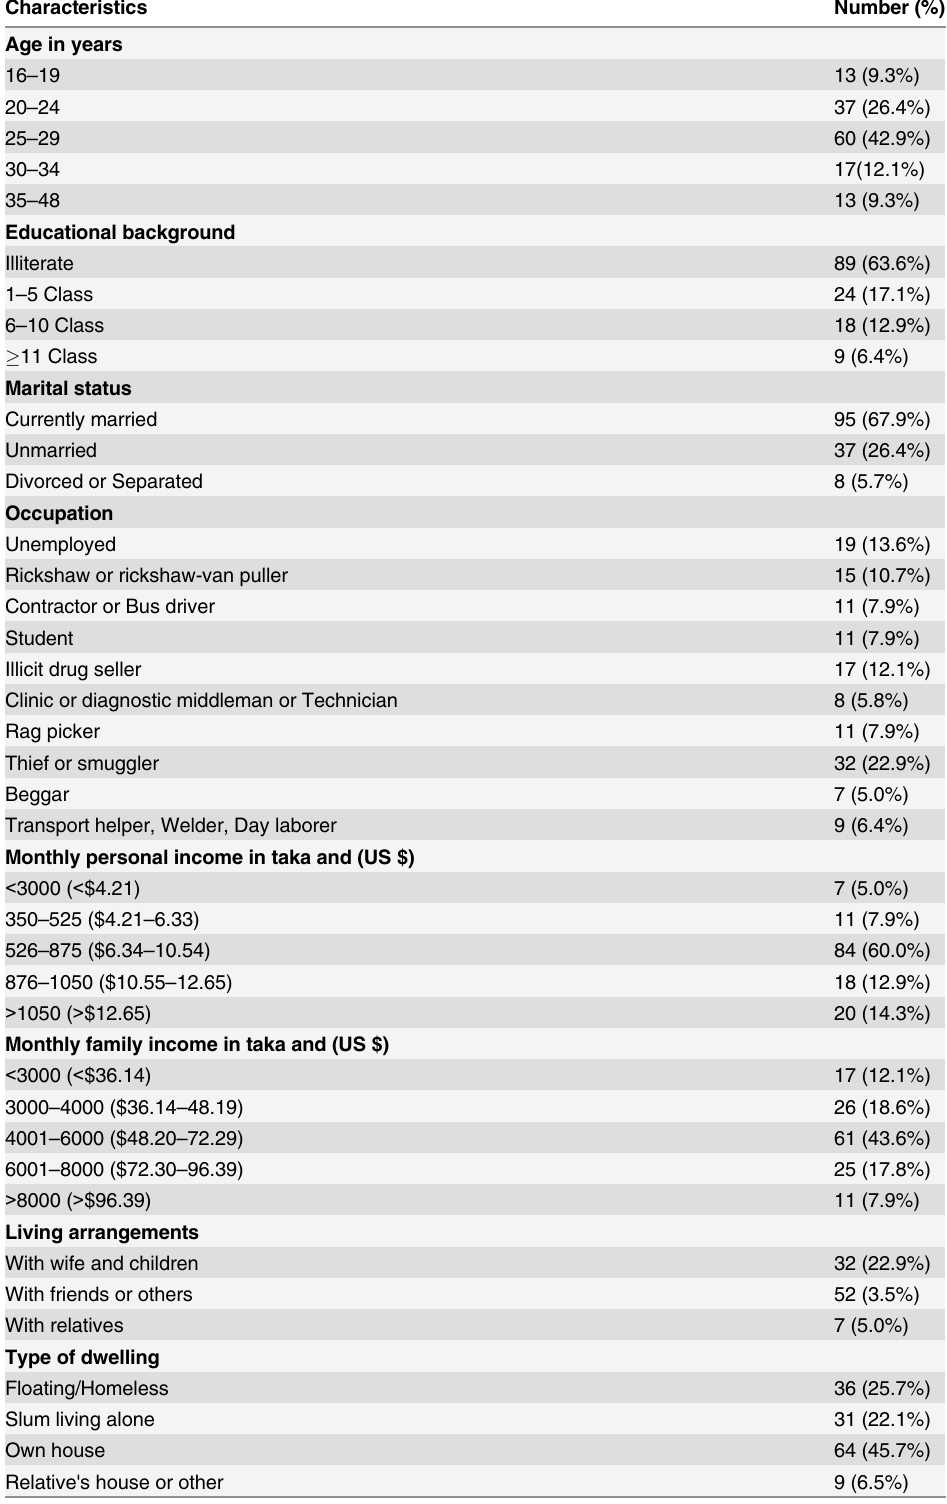
Table 1. Socio-demographic profile for 140 persons who inject drugs in Rajshani,